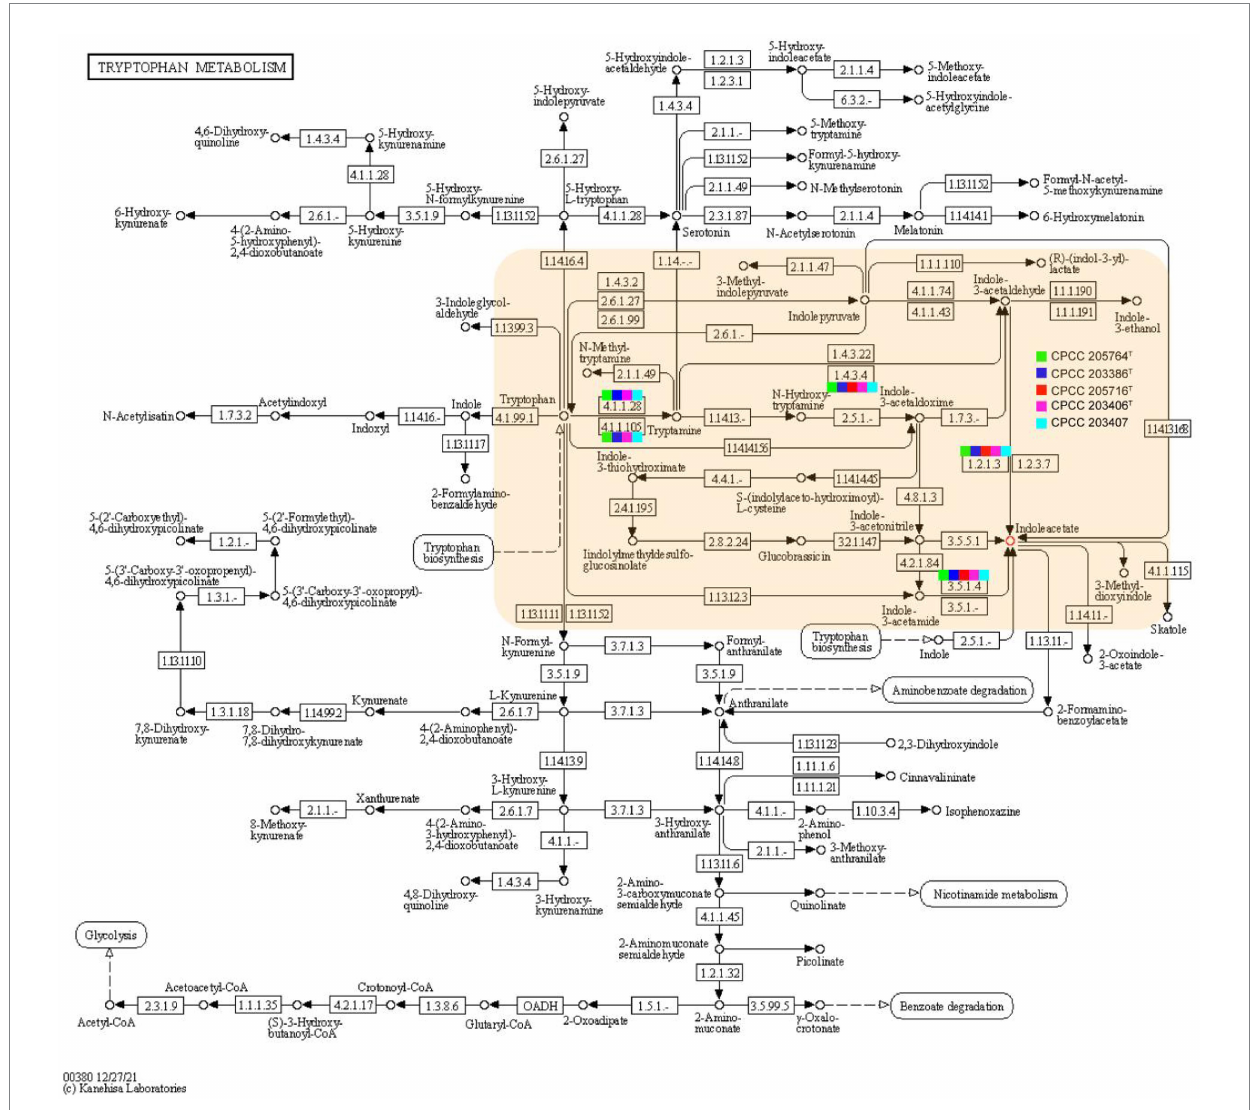
FIGURE 6 Putative overview of indole-3-acetic acid-producing pathway in the tryptophan metabolism pathways of the strains CPCC 205763 T , CPCC 203386 T , CPCC 205716 T , CPCC 203406 T , and CPCC 203407. The squares colored in green, blue, red, pink and light blue represents the strain CPCC 205763 T , CPCC 203386 T , CPCC 205716 T , CPCC 203406 T , and CPCC 203407,